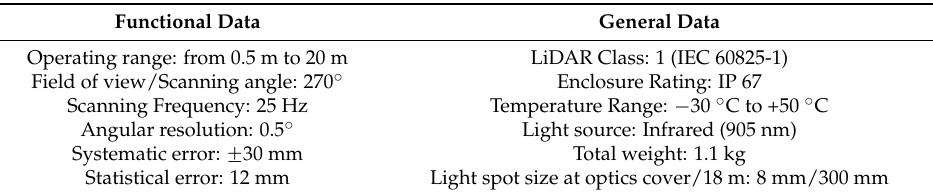
Table 1. LMS 111 technical data